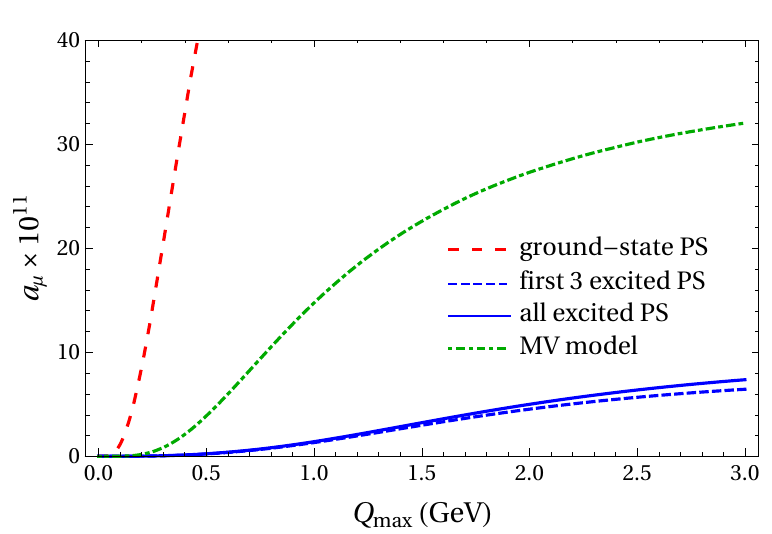
Figure 15. Same as (cid:12)gure 14, but for Q i (cid:20) Q max .